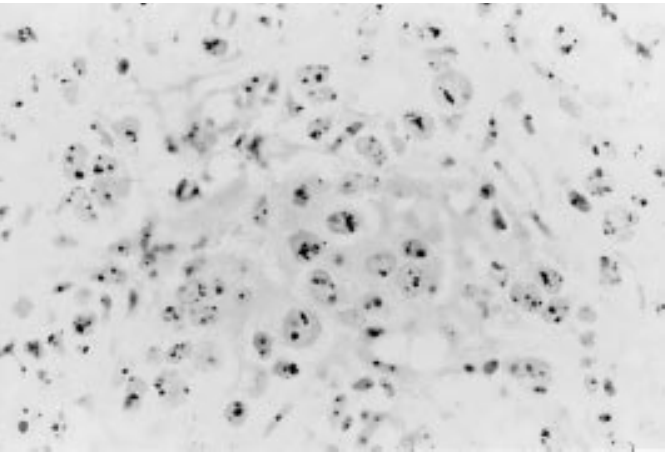
Fig. 2. High amount of AgNORs in an invasive ductal breast carcinoma of histopathological differentiation grade 3 ( (cid:2)